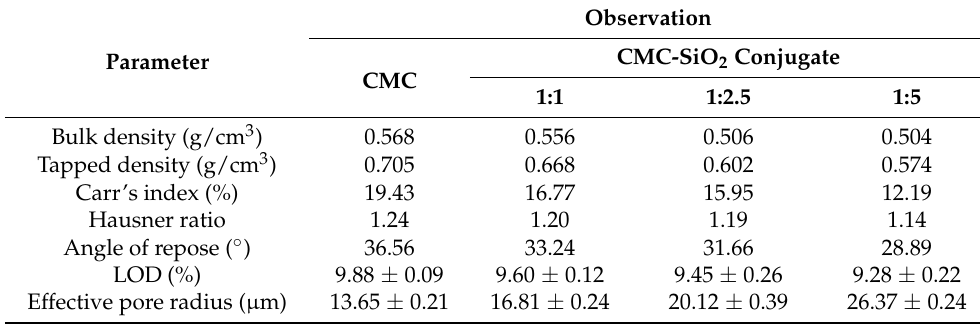
Table 3. Micromeritic study result for CMC and CMC-SiO 2 conjugates. Observation CMC-SiO 2 Conjugate Parameter CMC 1:1 1:2.5 1:5 Bulk density (g/cm 3 ) 0.568 0.556 0.506 0.504 Tapped density (g/cm 3 ) 0.705 0.668 0.602 0.574 Carr’s index (%) 19.43 16.77 15.95 12.19 Hausner ratio 1.24 1.20 1.19 1.14 Angle of repose ( ◦ ) 36.56 33.24 31.66 28.89 LOD (%) 9.88 ± 0.09 9.60 ± 0.12 9.45 ± 0.26 9.28 ± 0.22 Effective pore radius ( µ m) 13.65 ± 0.21 16.81 ± 0.24 20.12 ± 0.39 26.37 ± 0.24 Loss on drying for MCC-SiO 2 conjugates was found to be 9.53 ± 0.20% (1:1), 9.29 ±